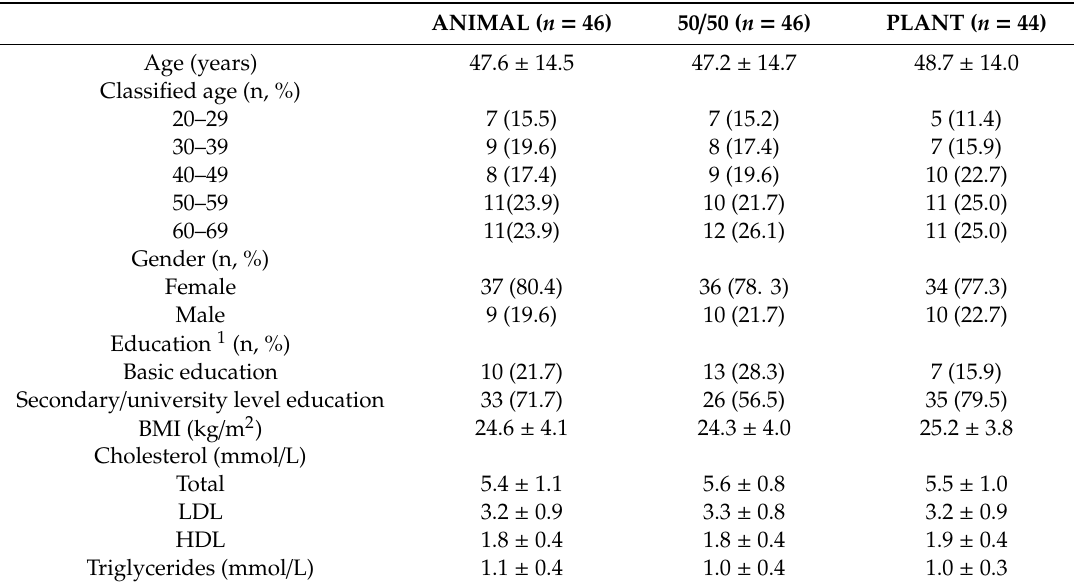
Table 2. Participant characteristics at the